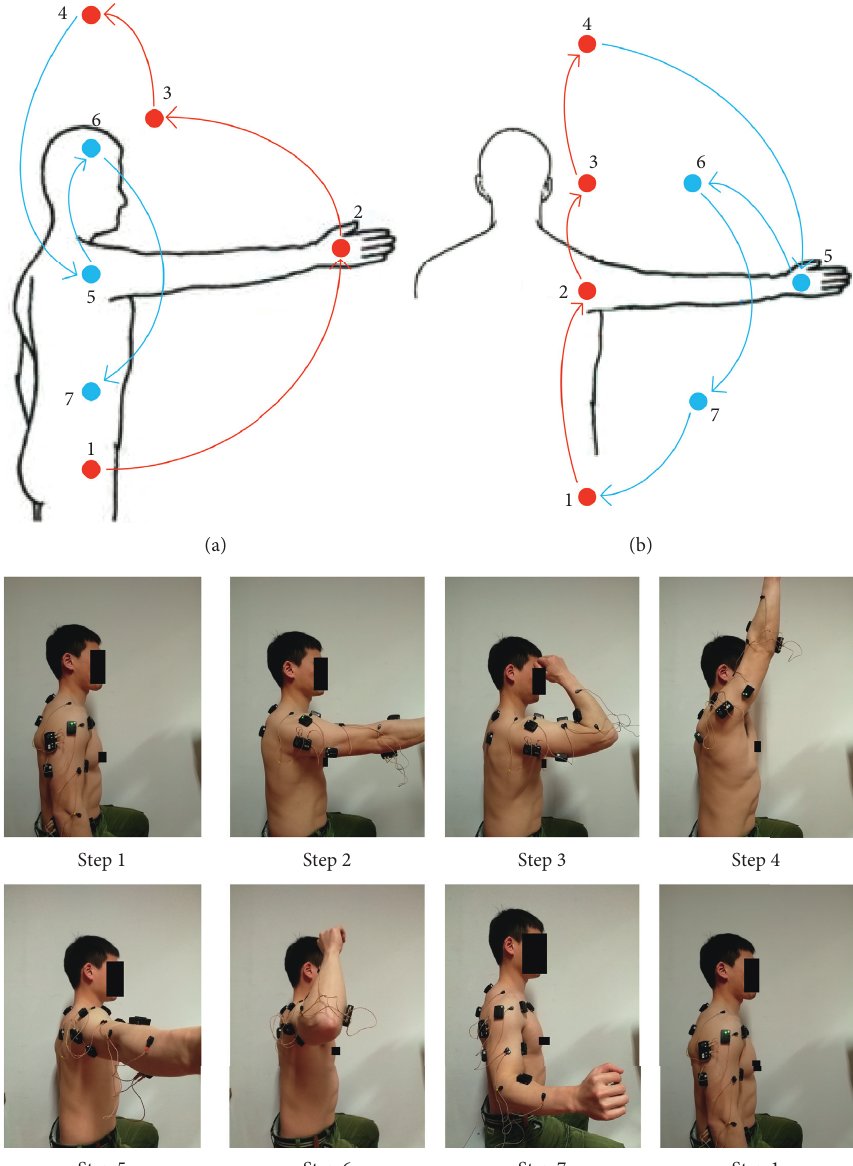
Figure 4: Upper limb movements recorded: steps 1-2-3-4-5-6-7-1. Schematic of the (a) right-hand side and (b) back side.